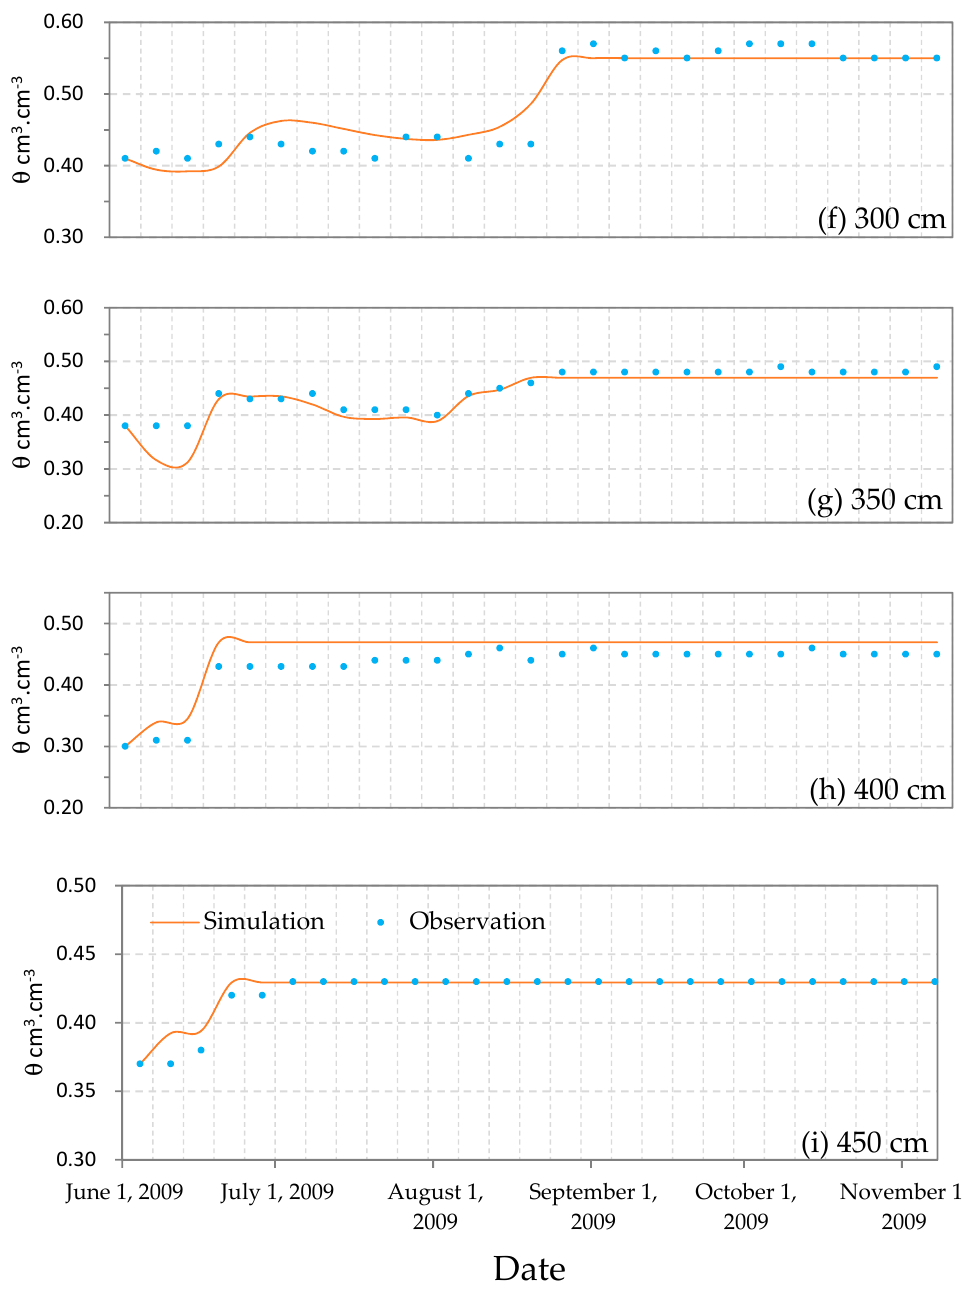
Figure 4. Measured (dots) and simulated (lines) volumetric soil water contents at depths of ( a ) 50, ( b ) 100, ( c ) 150, ( d ) 200, ( e ) 250, ( f ) 300, ( g ) 350, ( h ) 400, and ( i ) 450 cm from June to November 2009.